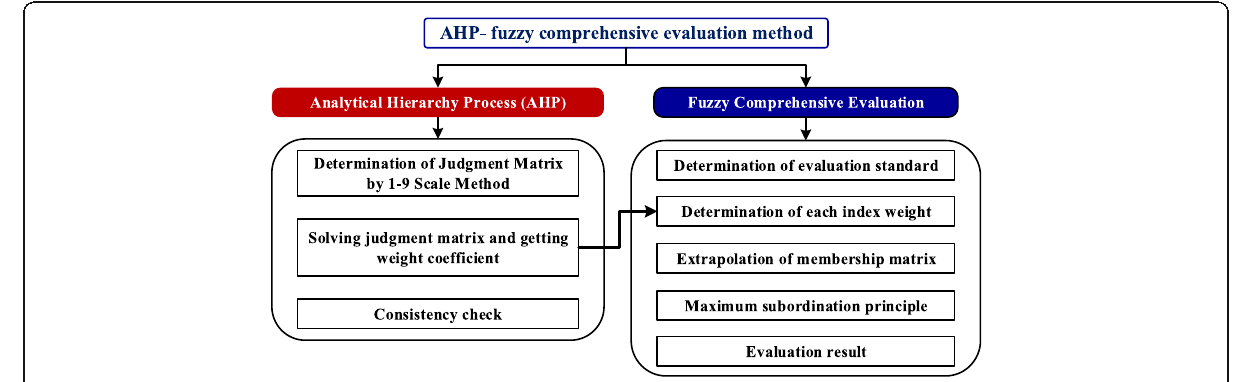
Fig. 2 The calculation process of AHP-fuzzy comprehensive